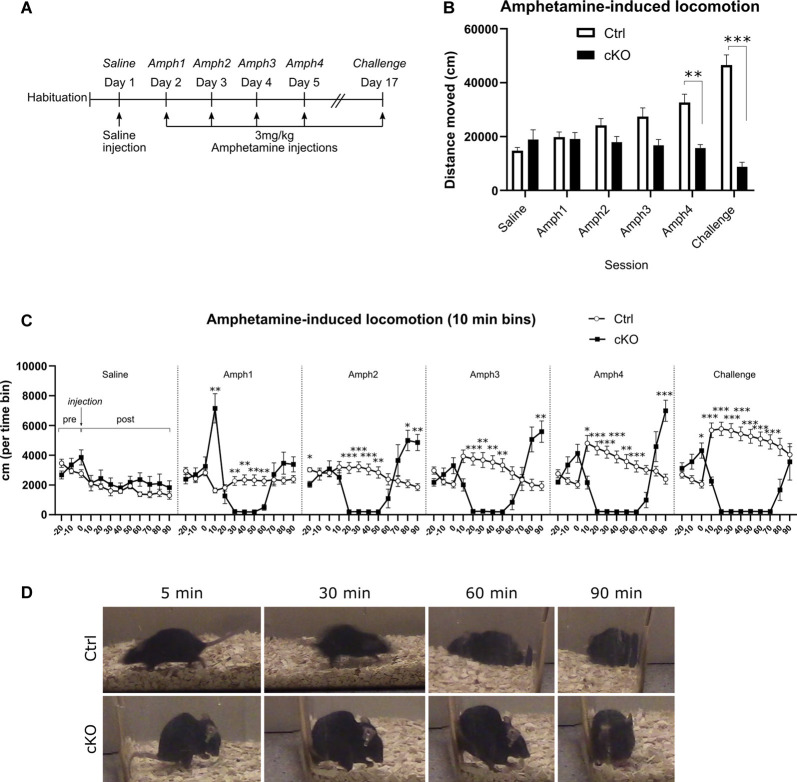
Amphetamine-induced locomotion. A sensitization paradigm (A) was applied to investigate the behavioral responses to amphetamine. Horizontal locomotion during 90 min following saline or amphetamine injections (B). Discrete 10-min segments of each session (C), including 30 min before injection (“pre”) and 90 min following injection (“post”). An example of the stereotypies exhibited at several time-points after injection of amphetamine (D). Data presented as mean ± SEM, *p < 0.05, **p < 0.01, ***p < 0.001.